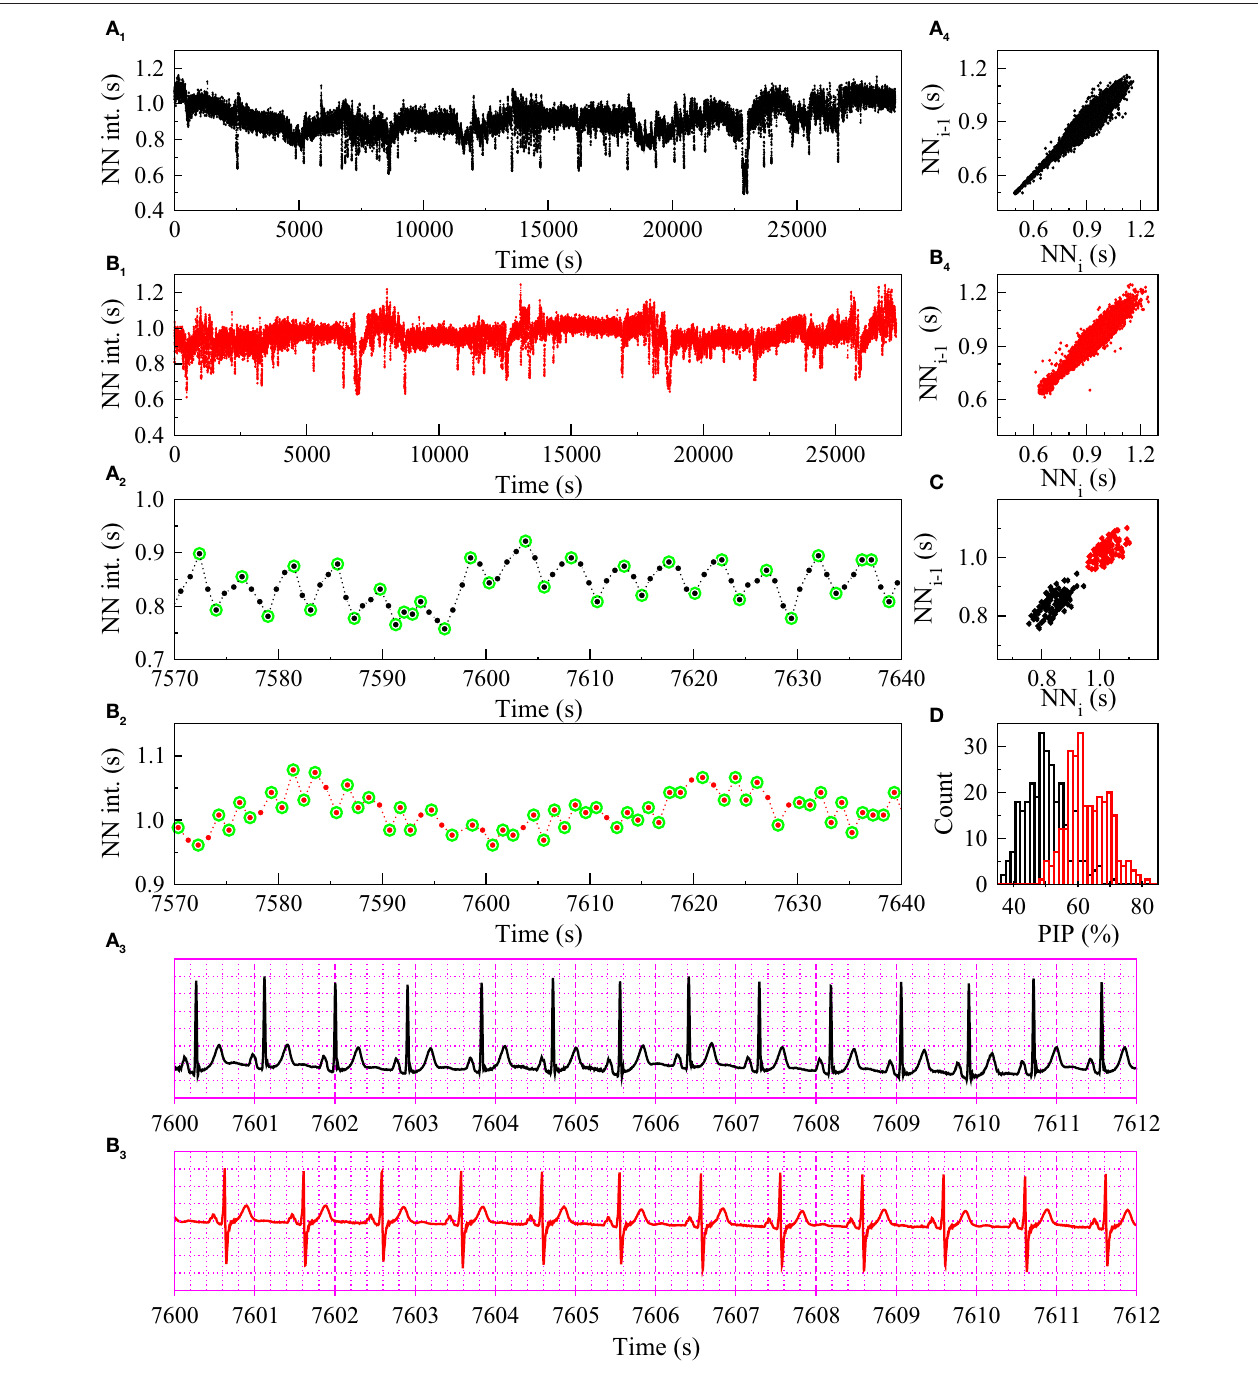
FIGURE 1 | Heart rate dynamics from two MESA participants, A with respiratory sinus arrhythmia (black tracings) and B with fragmented sinus rhythm (red tracings). Normal-to-normal (NN) sinus interval time series for the entire sleep period (A 1 ,B 1 ) and for a 70-second window (A 2 ,B 2 ) . Twelve-second ECG recordings (A 3 ,B 3 ) . Poincare plots for the entire sleep period (A 4 ,B 4 ) and the 70-second NN time series shown in A 2 and B 2 (C) . The green circles highlight the “inflection points,” where the changes in heart rate acceleration sign occur. Histogram of the percentage of inflection points (PIP) calculated with a moving window of 1000 NN intervals (D) . Neither participant had prevalent or incident CVEs. However, they were in two different risk categories: the Framingham CVD risk index was 2.4 (1st percentile of MESA participants) for A and 15.6 (55th percentile) for B . The time series from participant B was 30% more fragmented (average PIP = 65%) than the one from participant A (average PIP = 50%). Traditional HRV and DFA α 1 indices were comparable: mean NN interval, 906 and 957 ms; rMSSD, 25.3 and 27.6 ms; pNN50, 5.0 and 6.5%; HF power, 348 and 310ms 2 ; DFA α 1 , 1.05 and 1.18, for participants A and B , respectively.